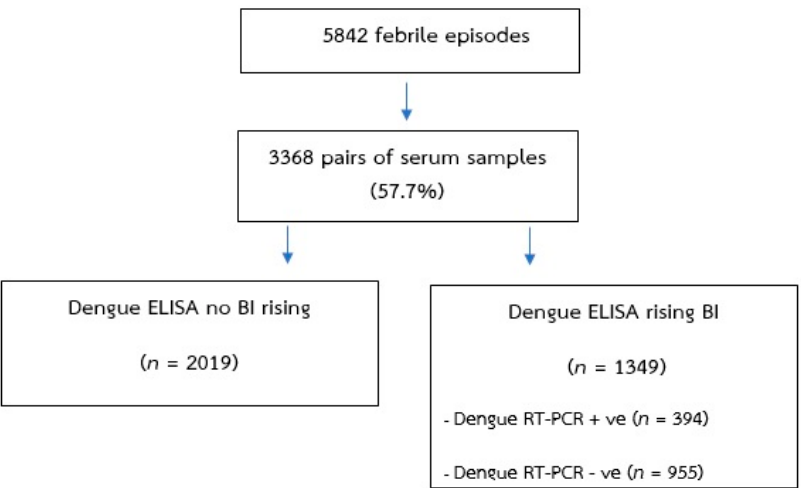
Figure 2. Schematic diagram of the study design and procedures. Specimens collected from children with acute febrile illness. All paired serum samples were used to perform dengue immunoglobulin (Ig)M/IgG enzyme-linked immunosorbent assay (ELISA) tests. The ELISA optical density results were transformed to binding index units.